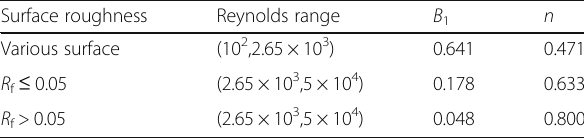
Table 1 Nusselt number parameters Surface roughness Reynolds range